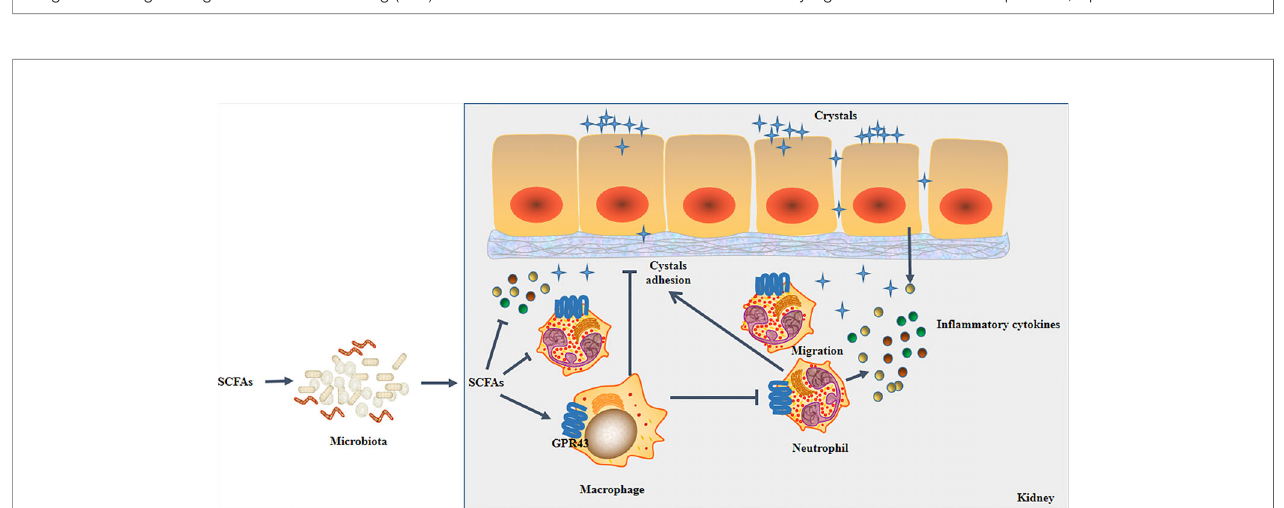
FIGURE 15 | Schematic overview of SCFAs on renal CaOx crystal formation through immunomodulation.